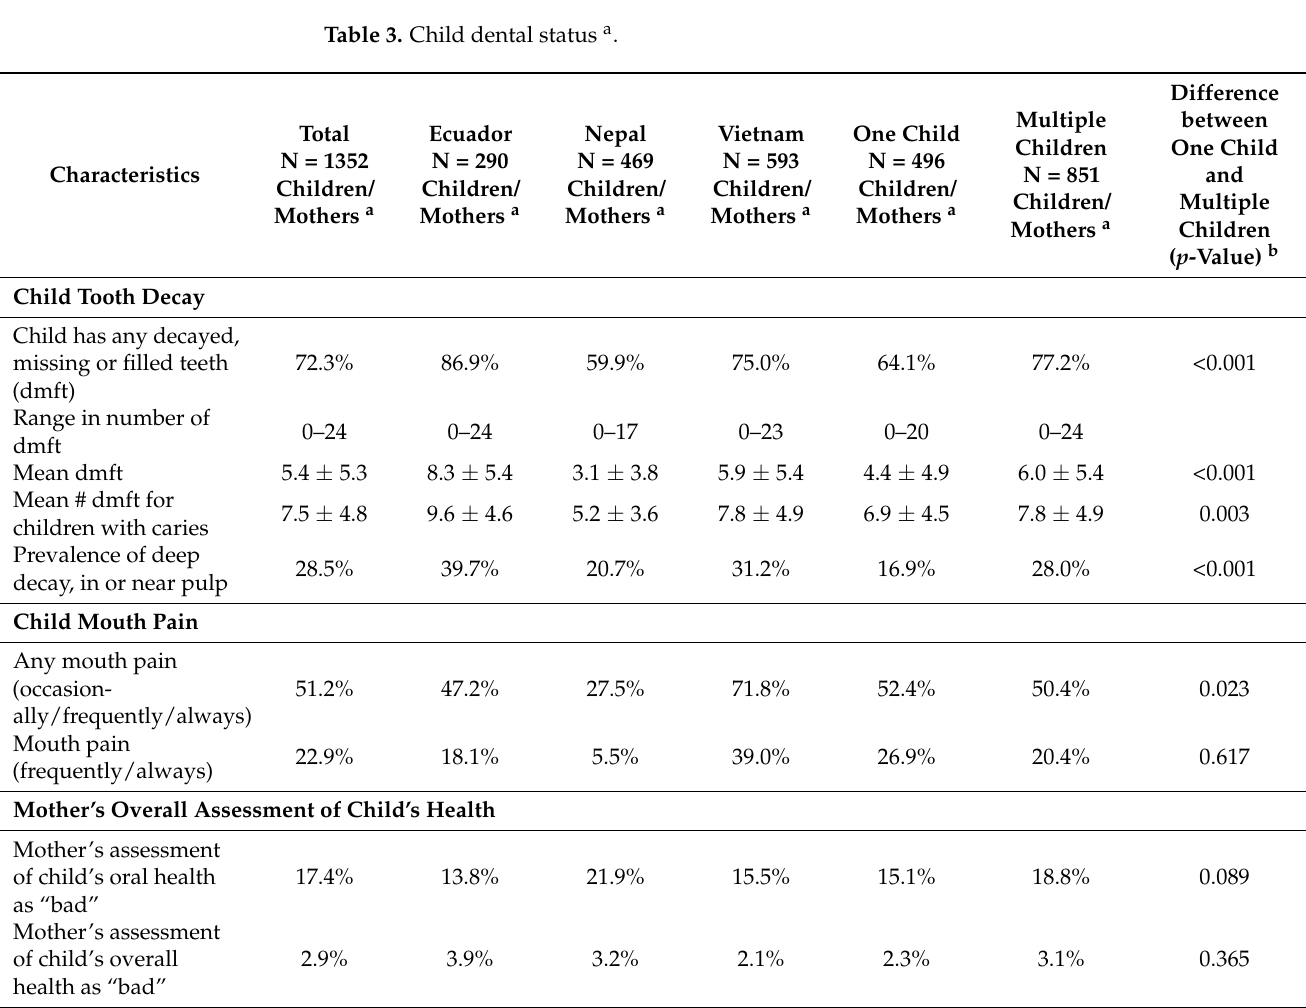
Table 3. Child dental status a